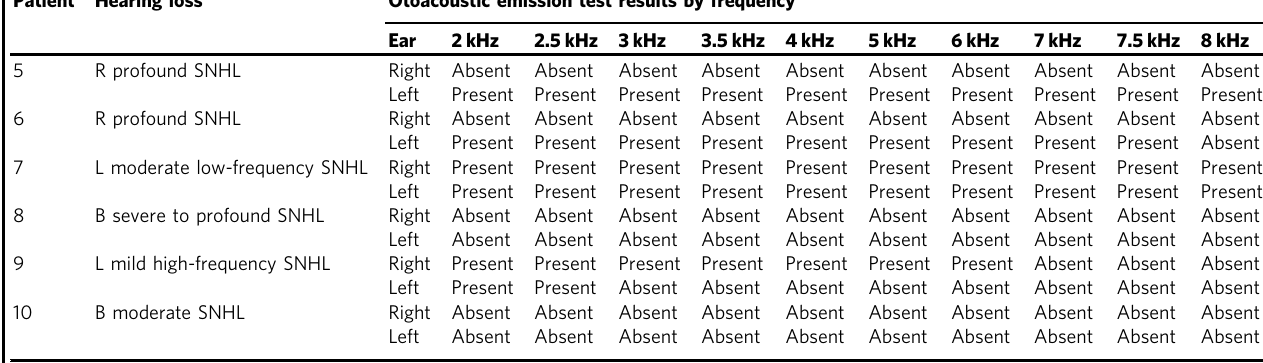
Table 1 Otoacoustic emission test results re fl ecting cochlear outer hair cell function. Patient Hearing